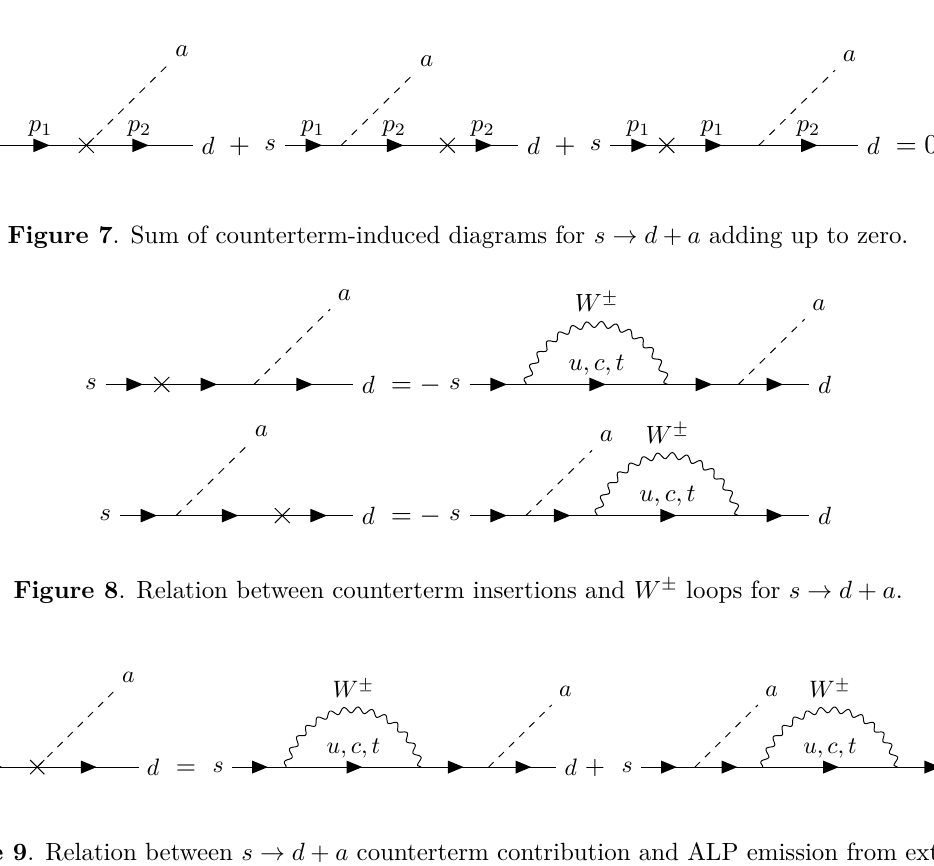
Figure 9 . Relation between s → d + a counterterm contribution and ALP emission from external